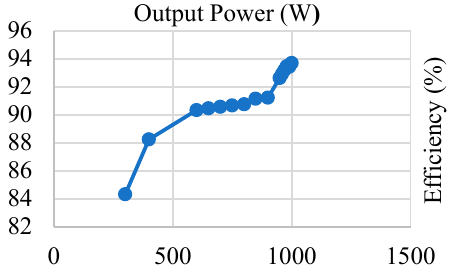
Figure 10. Output power vs. efficiency curve.